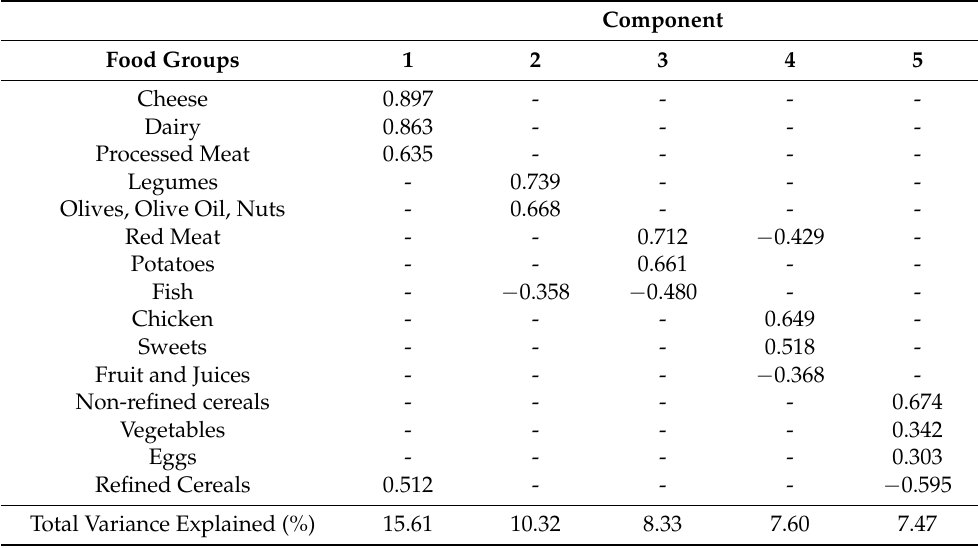
Table 3. Principal Components Analysis’ factor loadings for the 15 food groups in the TEENAGE study ( n =